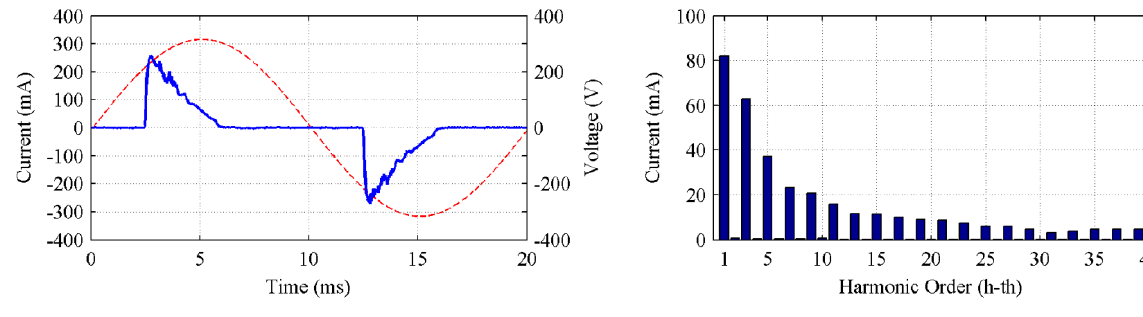
Figure 14. CFL-D: current waveform and its harmonic